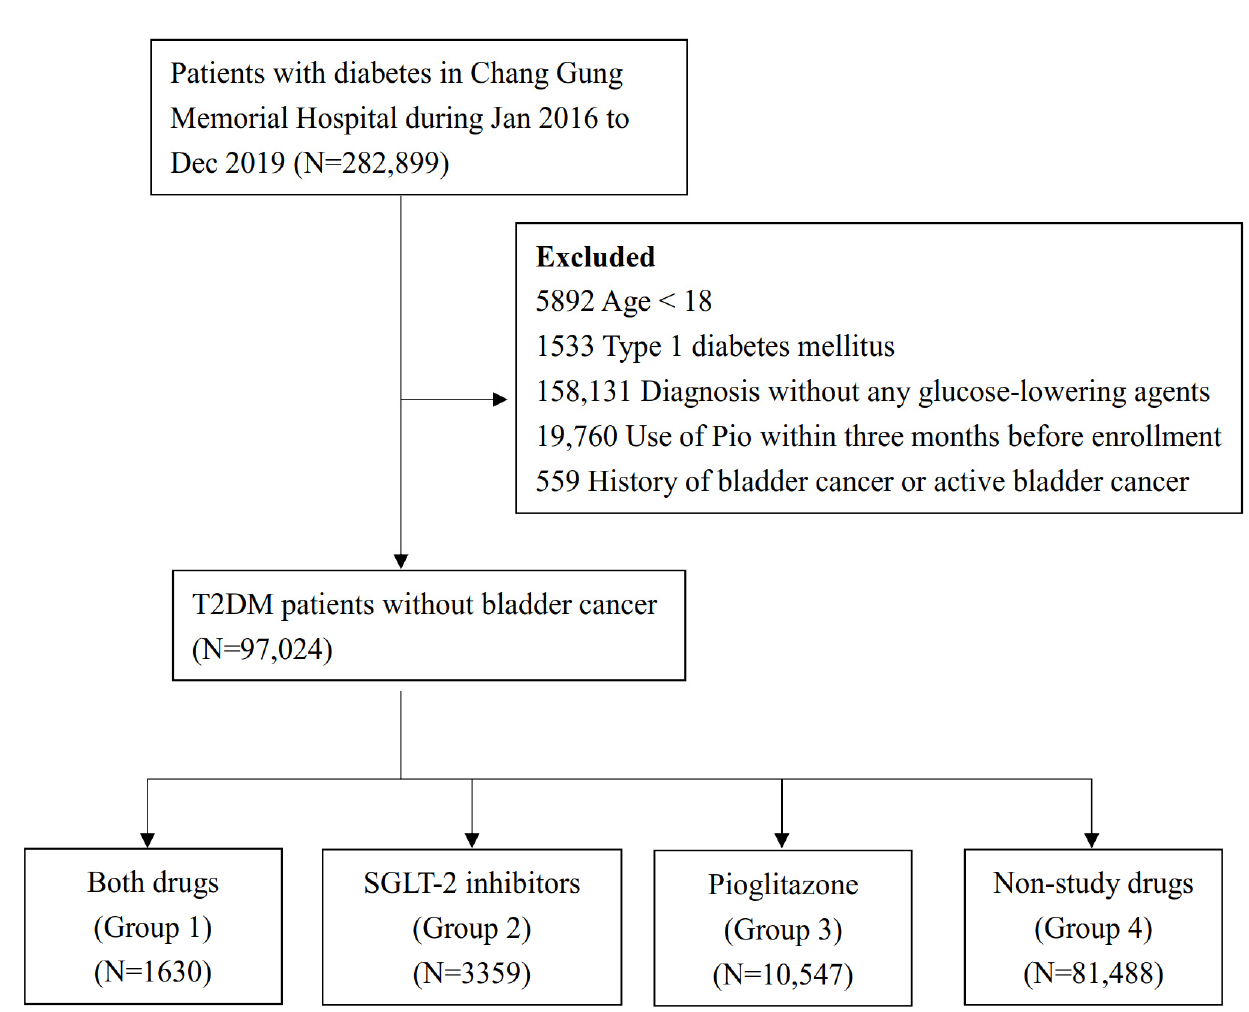
Figure 1. Flowchart of patient selection.